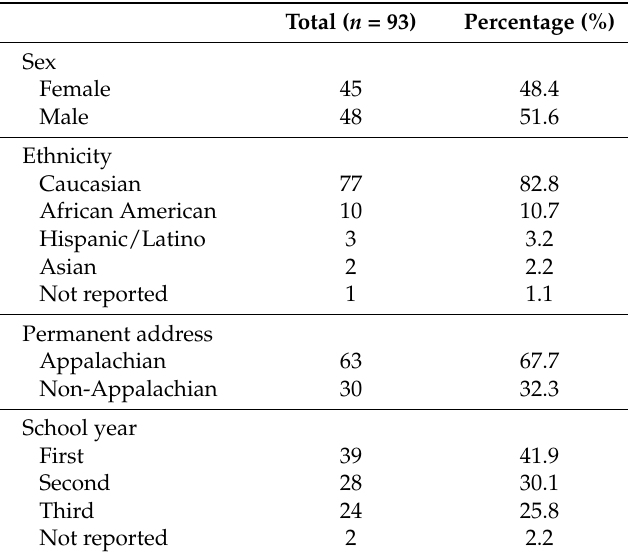
Table 1. Sample descriptive characteristics.